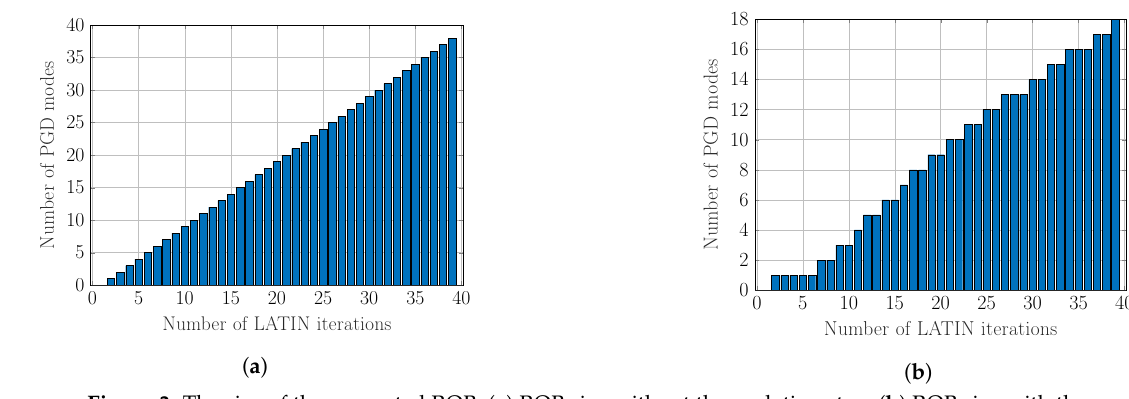
Figure 3. The size of the generated ROB. ( a ) ROB size without the updating step; ( b ) ROB size with the updating